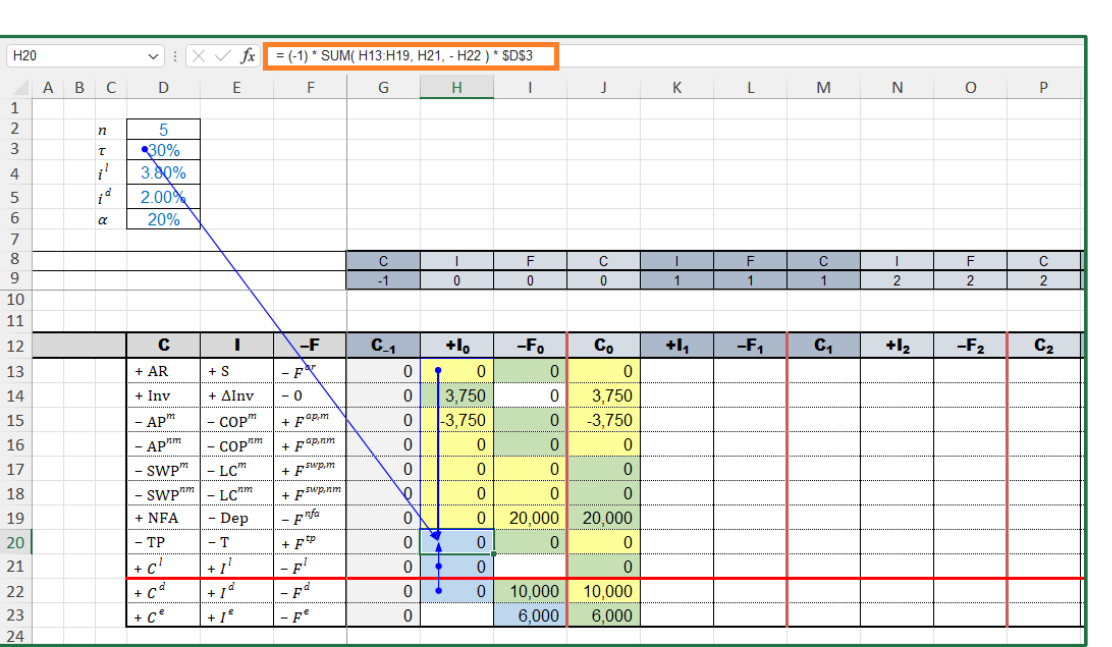
Figure 16. The cells whose values are calculated with suitable formulas are shown in blue. Cell H20 contains the specific formula for calculating the taxes (“SplitScreenStrip” sheet). (The cells whose values are provided in “PreCalc” are in yellow, the cells whose values are calculated with the law of motion are in green, and the cells whose values are calculated via suitable formulas are in blue.)